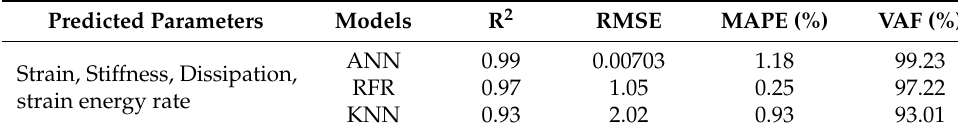
Table 6. Performance indices of the developed models.